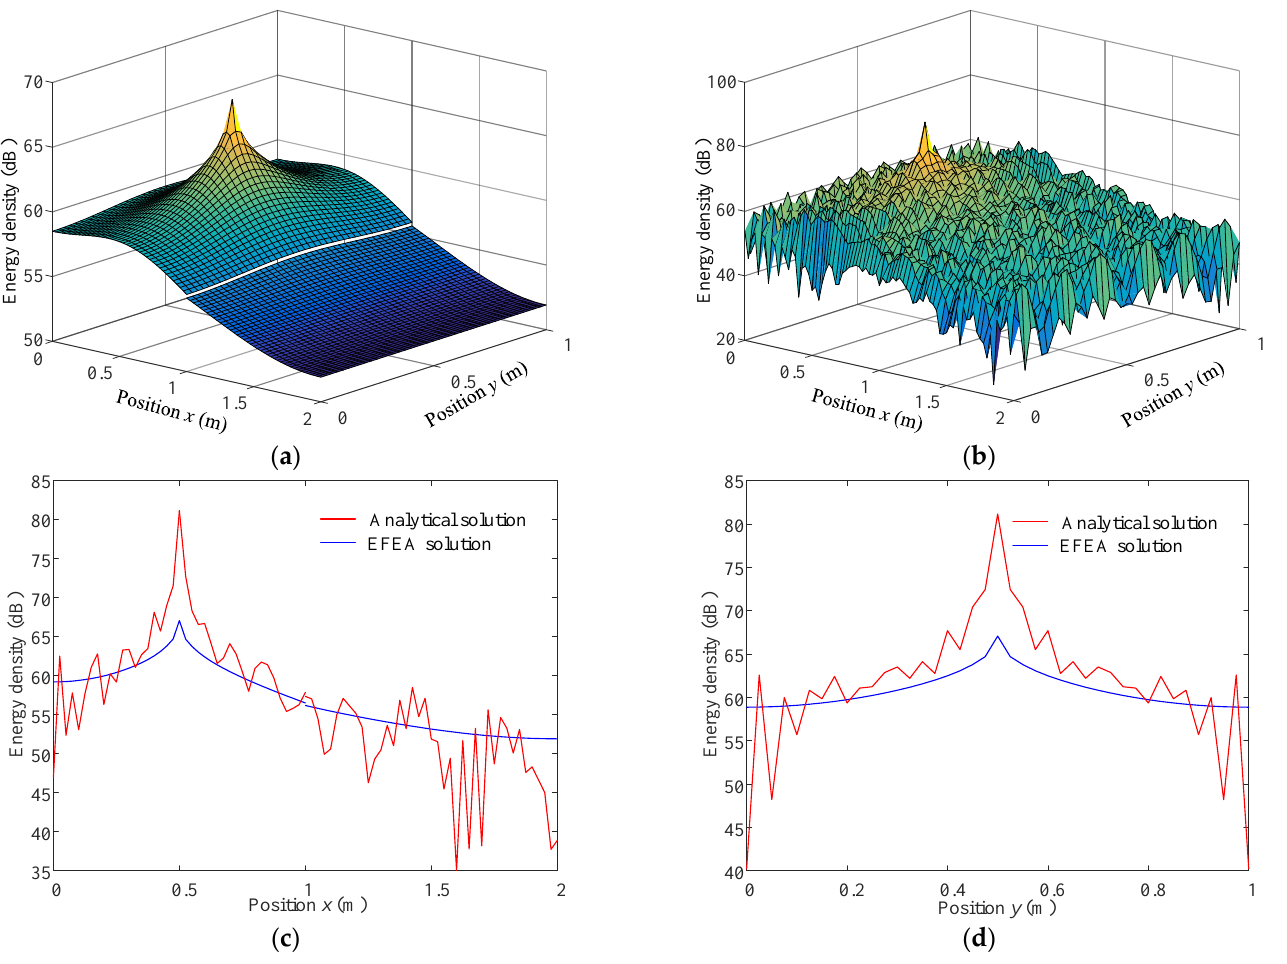
Figure 9. Energy density distribution for a plate with PFLD treatment ( f = 3 kHz, η 2 = 0.8, h 2 = 0.003 m). ( a ) EFEA solution. ( b ) Analytical solution. ( c ) Energy density distribution at y 0 = 0.5 m. ( d ) Energy density distribution at x 0 = 0.5